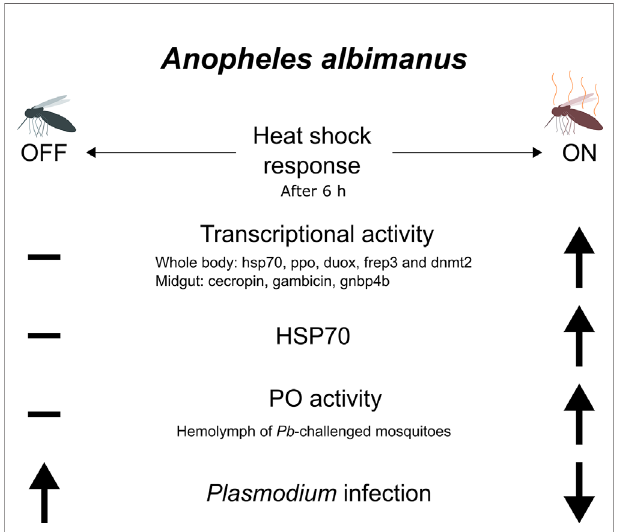
FIGURE 6 | Schematic summary. After a 6 h of a 30 min heat shock at 37°C, several immune genes are upregulated in the mosquitoes. These include genes that have been shown responsible for limiting a Plasmodium infection such as ppo , duox , frep3 in the whole mosquito, and antimicrobial peptides in the midgut. hsp70 is also upregulated along with dnmt2 , a gene responsible for the methylation of DNA and RNA in mosquitoes. This might indicate an increment in methylcytosines in the nucleic acids, which is also supported by the down regulation of the enzyme that removes these epigenetic marks, tet2 (not shown). The PO activity also increases in the hemolymph of the Plasmodium -challenged and heat-shocked mosquitoes, although the total amount of NO produced did not changed (not shown). This overall response caused the mosquitoes to become less infected with the parasite. Only statistically signi fi cant results are